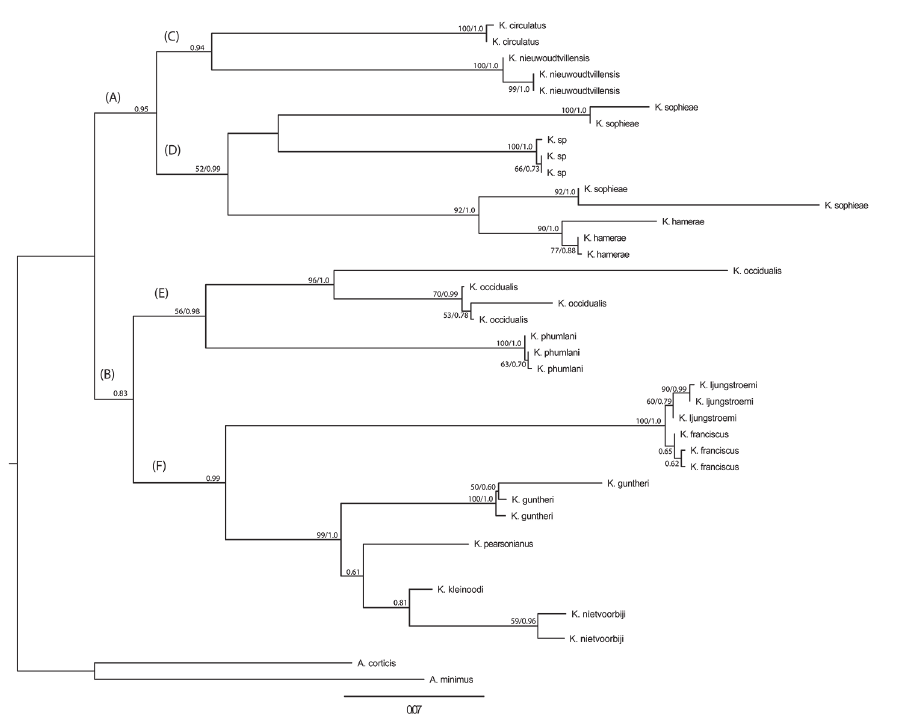
Figure 1. COI gene phylogram showing relationships amongst Kazimierzus species. Numbers above nodes are bootstrap support/posterior probabilities from Maximum Likelihood and Bayesian analyses. Letters A–F represents different